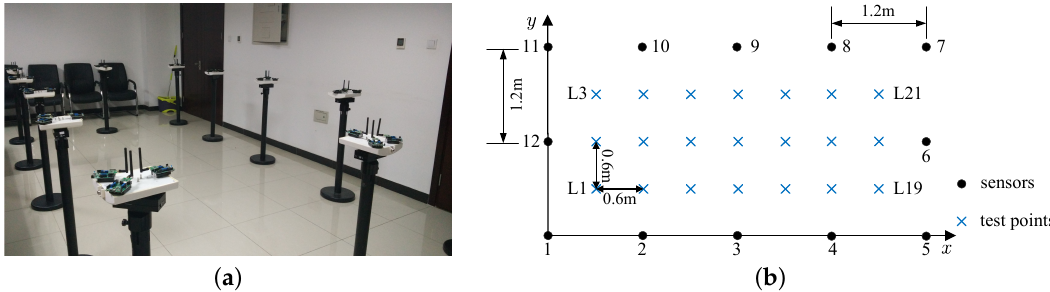
Figure 3. Conference room: ( a ) photography; ( b ) layout. In the test, the orientation of the target is perpendicular to the y